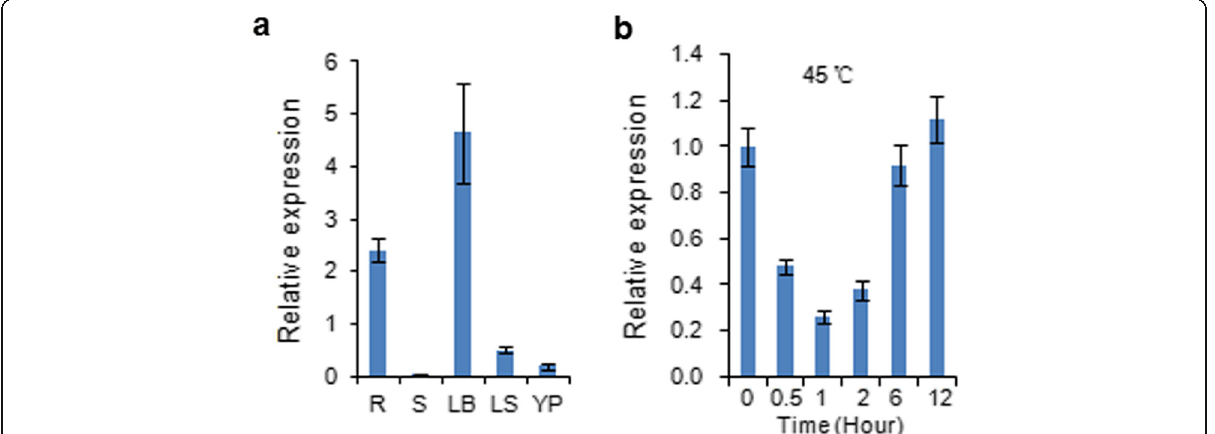
Fig. 1 Expresson pattern of OsProDH . a Tissue-specific expression of OsProDH detected by qPCR. R: root; S: stem; LB: leaf blade; LS: leaf sheath; YP: young panicle. Roots were sampled from two-leaf stage seedlings. Stem, leaf blade, leaf sheath were sampled from two-month old plants. Panicle in 5 cm length. The data shown are the mean values of three technical repeats with the SD. b Transcriptional response of OsProDH to high temperature stress. Two-leaf stage KY131 seedlings were subjected to 45 °C treatment and OsProDH expression was determined in the shoots at the indicated time points by qPCR analysis. OsActin was used as internal control. The data shown are the mean values of three technical repeats with the